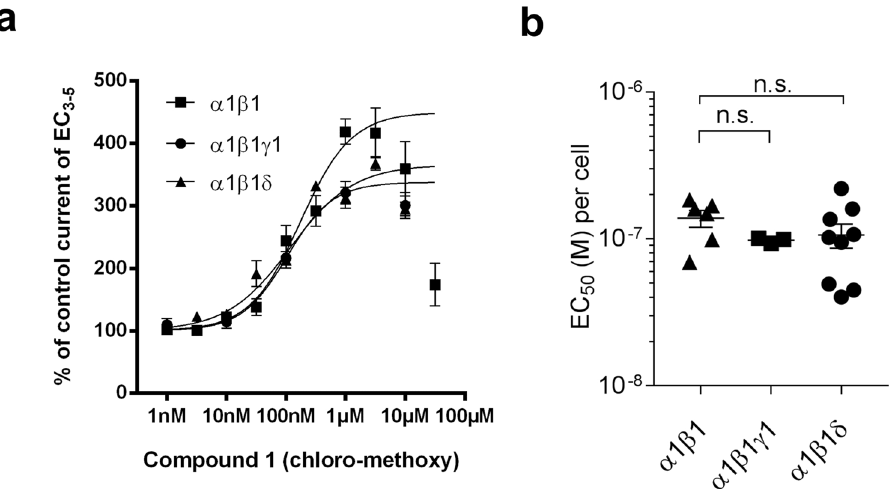
Figure 5. Compound 1 modulates GABA-evoked currents in α 1 β 1, α 1 β 1 γ 1 and α 1 β 1 δ receptors with similar potencies. ( a ) Concentration-dependent modulation of GABA EC 3–5 current at α 1 β 1, α 1 β 1 γ 1 and α 1 β 1 δ . Data represent means ± SEM (n = 3–10). ( b ) EC 50 values were calculated for each individual experiment and are presented as mean ± SEM. One-Way ANOVA was used for multiple comparisons followed by a Tukey post hoc test and showed no significant differences between the mean EC 50 values for each subtype.